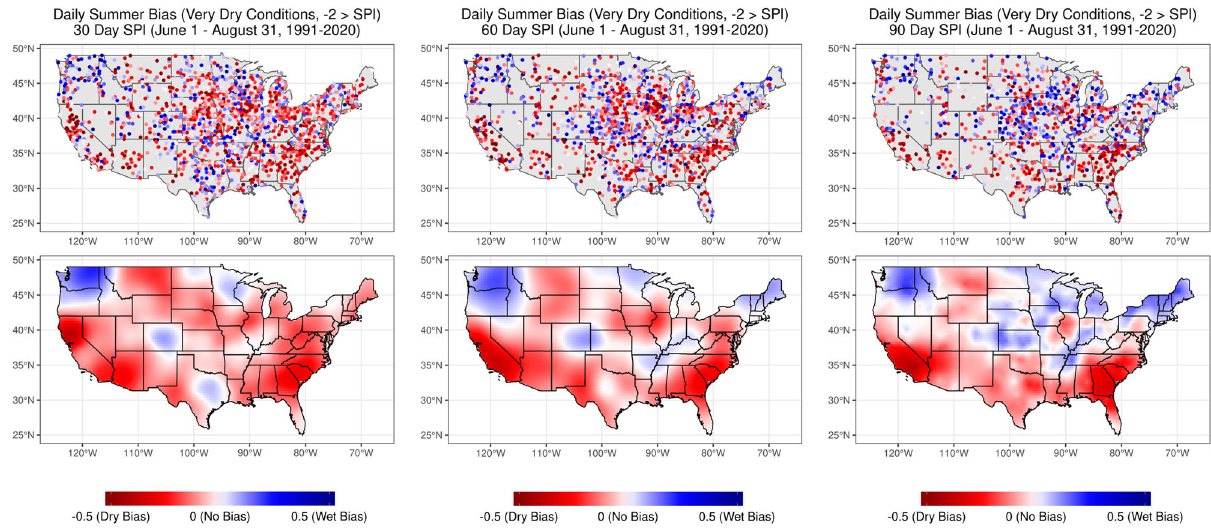
Fig. 5 Standardized Precipitation Index (SPI) bias for Global Historical Climatology Network (GHCN) sites across the United States during periods with SPI < − 2 (very dry conditions) de fi ned using the period-of-record SPI timeseries. Bias was computed as the median daily difference between the period-of-record SPI and the 30-year ( “ contemporary ” ) SPI from June 1 to August 31, 1991 – 2020. Dry bias (represented by red) denotes locations where the period-of-record reports conditions that are drier than the most recent 30 years for [left] 30-day, [middle] 60-day and [right] 90-day